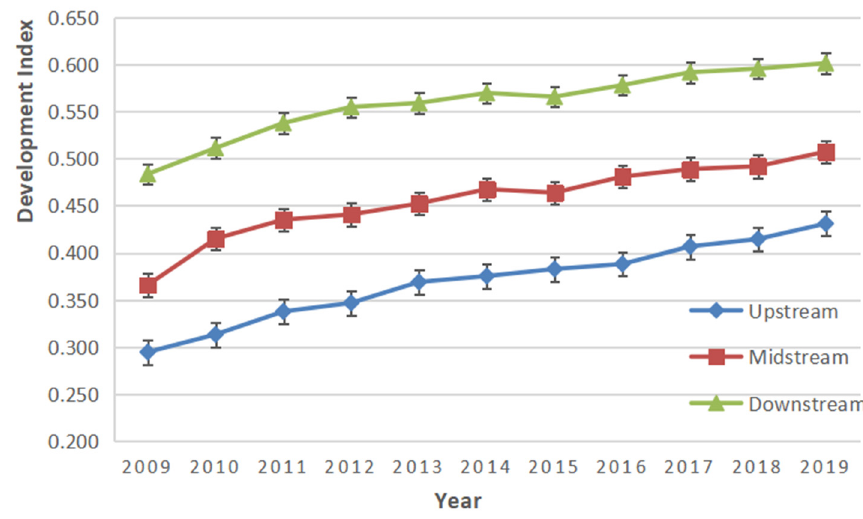
Figure 4. Coordinated development trend of upstream, midstream, and downstream.